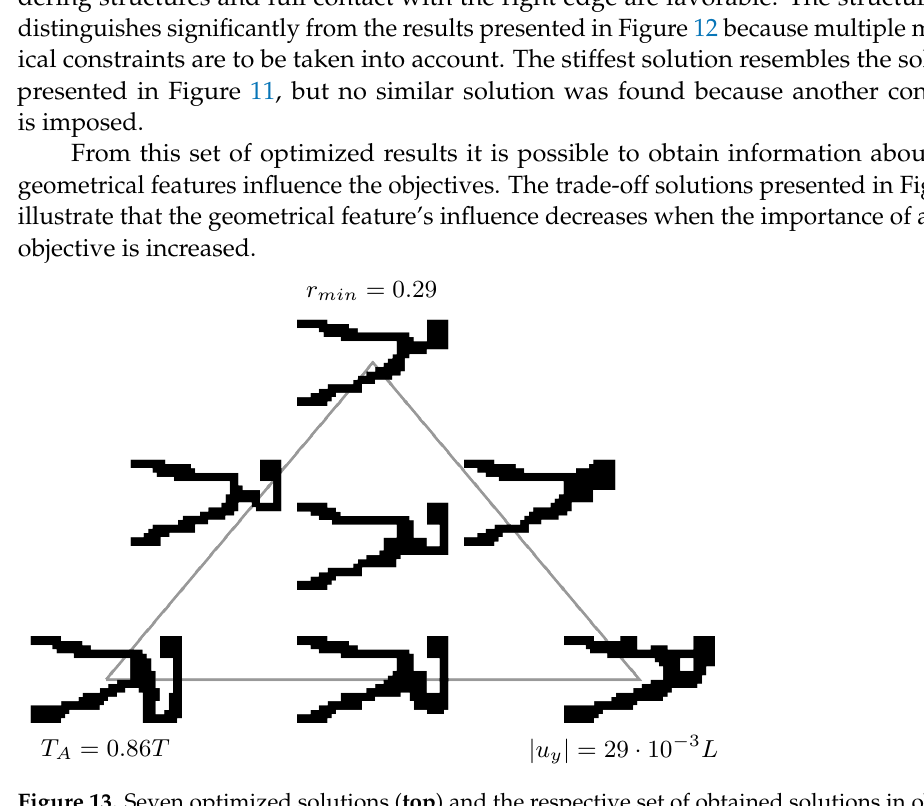
Figure 13. Seven optimized solutions ( top ) and the respective set of obtained solutions in objective space ( bottom ) to the design problem in Figure 7. Optimization was carried out with respect to the displacement and the temperature in A and the relative volume r . The edges of the triangle show structures that optimize one objective, the sides show structures that are a trade-off between two objectives and the structure in the center is a trade-off between all three